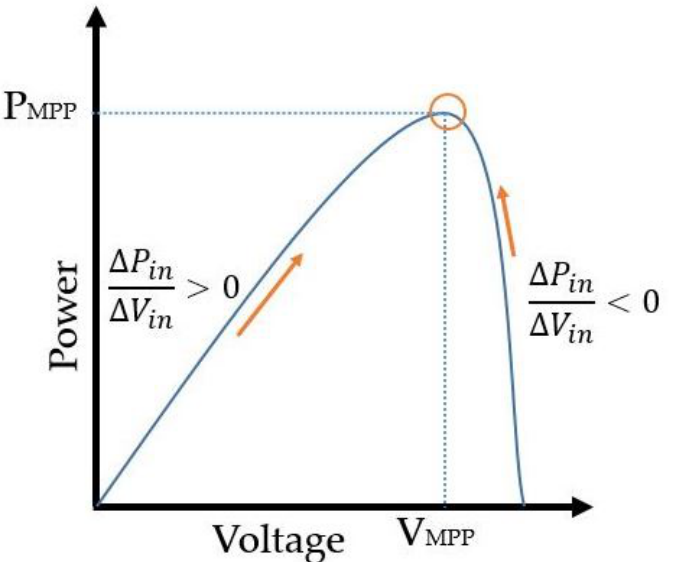
Figure 3. Principle of the hill climbing algorithms for